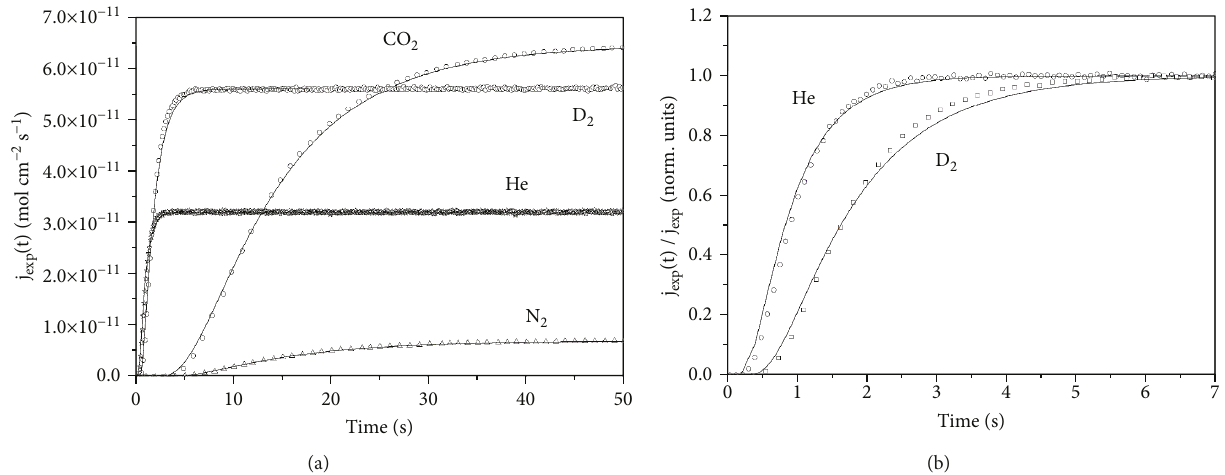
Figure 4: (a) Permeation fl ux curves j are fi tting of the experimental curves; see text. (b) Normalized j = 40 kPa. Lines are the j and P HPS